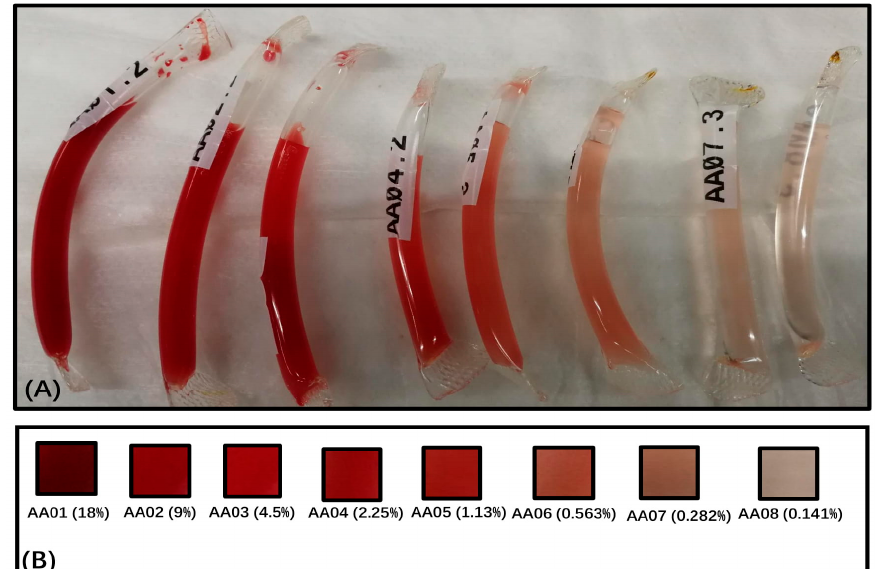
Figure 3. The blood concentration samples prepared for the series of experiments as shown in Section ( A ). The blood samples are prepared in the serial dilution method, whereby the most concentrated blood sample is prepared first and then subsequently diluting the sample by halving the concentration of the blood sample. Section ( B ) specify the blood concentration in the mixture and its corresponding colours and sample names.